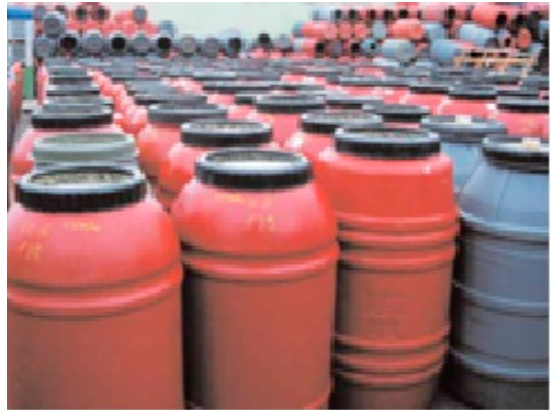
Figure A1. Di ff erent types of industrial plastic barrels used in the black table olive Figure A1. Different types of industrial plastic barrels used in the black table olive processing.